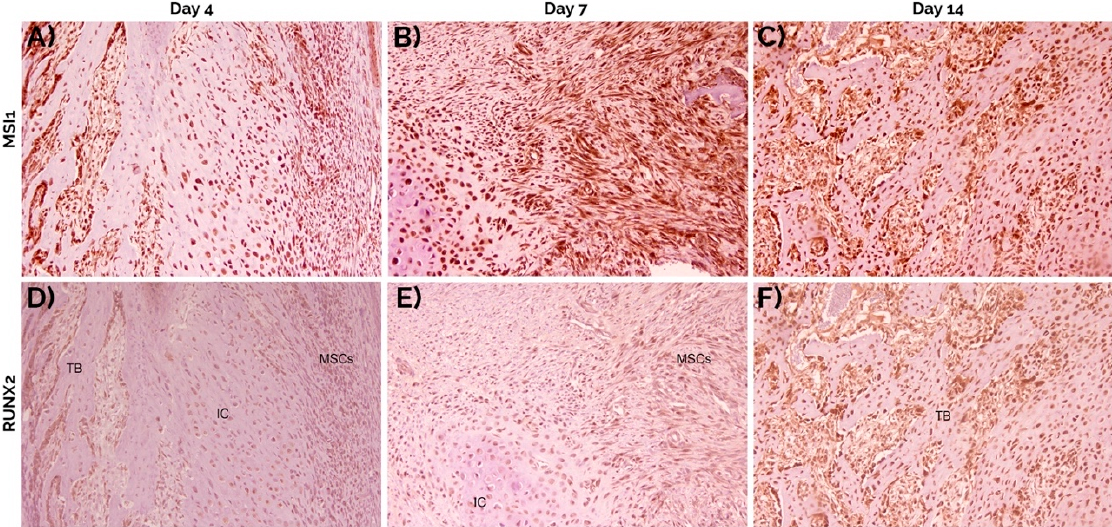
Figure 8. Staining of consecutive sections at 4 ( A , D ), 7 ( B , E ) and 14 days ( C , F ) for musashi-1 ( A – C ) and RUNX2 ( D – F ). Both markers increased over time. In general, the same cell types expressed both musashi-1 and RUNX2. Peroxidase-conjugated micropolymer detection. TB: trabecular bone; IC: immature chondrocytes; MSCs: mesenchymal stromal cells. Original magnification: 10×.